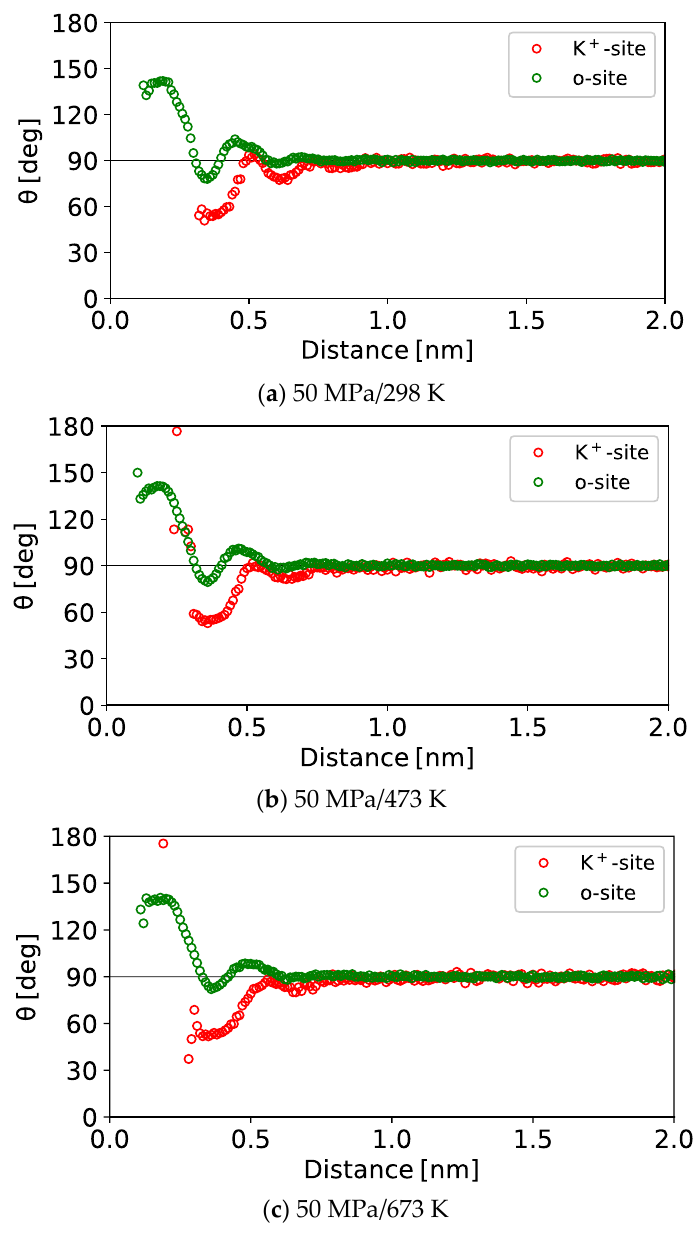
Figure 10. Profiles of the orientation angle θ on K + -site (red) and o-site (green) .